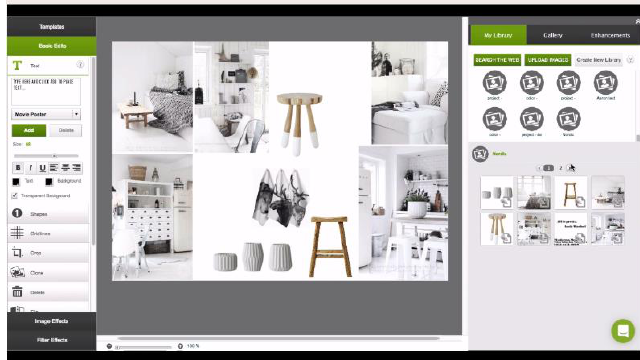
Figure 2. SmpleBorad laboratory e-webpage platform.